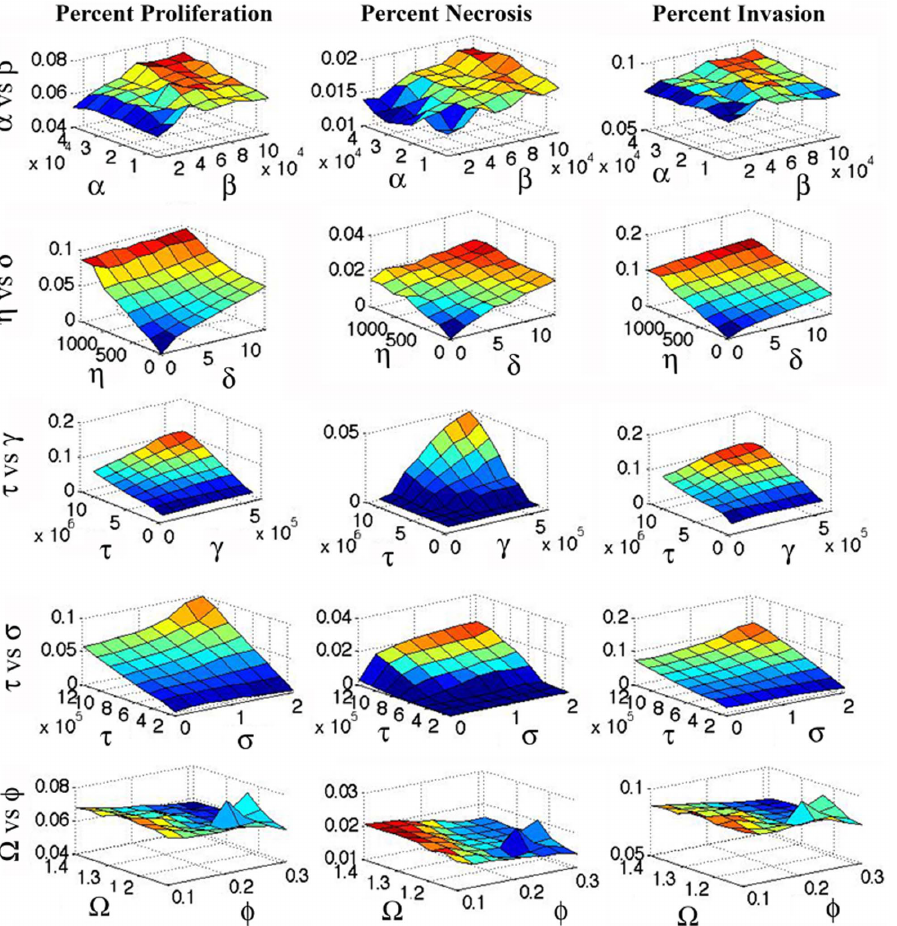
Fig. 4. Sensitivity Analysis. Percent Proliferation ( w 10 { 1 P ), Percent Necrosis ( w 90 % brain death), and Percent Invasion ( w 10 { 4 I ) for different parameter choices at time 5 3000. a , transition rate from P to I . b , transition rate from I to P . g , active transport of I cells. d , diffusion coefficient of I cells. t , mitotic rate